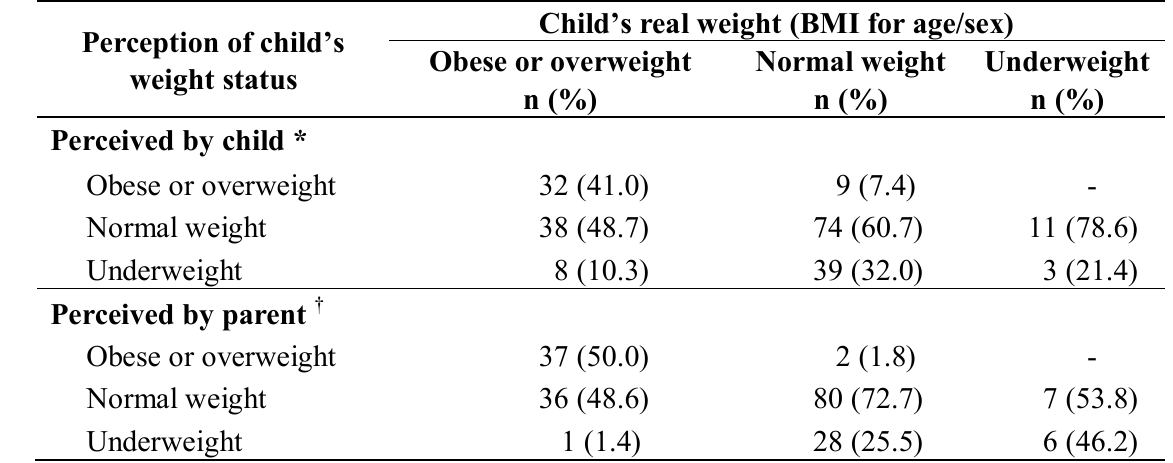
Table 3. Relationship between Real and Perceived Weight Status among Elementary School Students, Cayey, Puerto Rico, 2008.